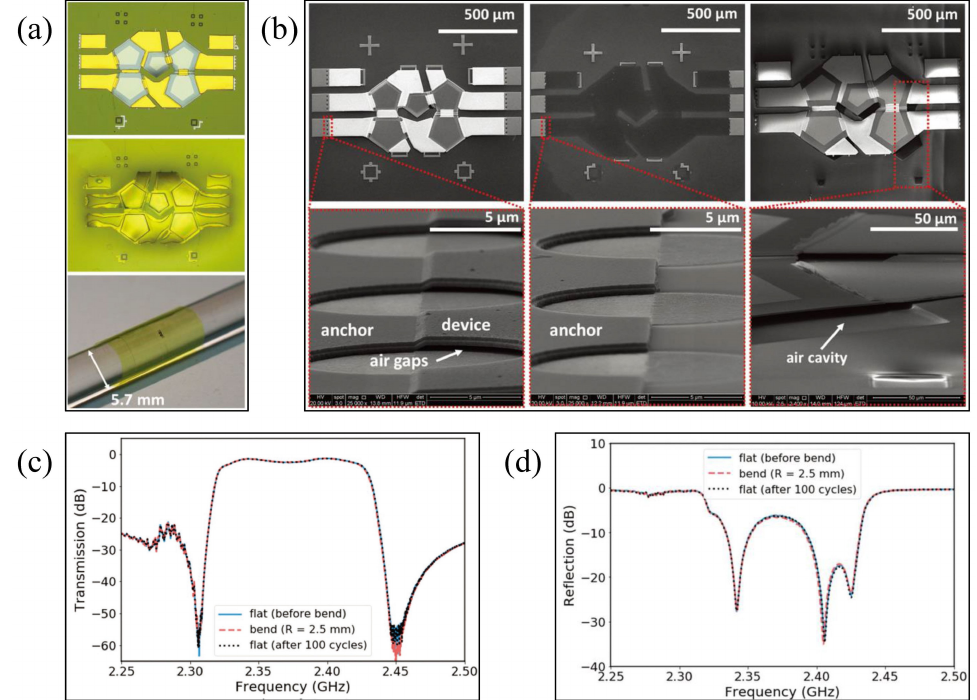
Figure 8. ( a ) Microscopic images of the flexible filter and the bent flexible filter [98] Reprinted/adapted with permission from Ref. [98]. 2018, John Wiley and Sons. ( b ) SEM images of the flexible filter [98] Reprinted/adapted with permission from Ref. [98]. 2018, John Wiley and Sons. ( c ) Transmission (S21) and ( d ) reflection (S11) performances of the flexible filter [98] Reprinted/adapted with permission from Ref. [98]. 2018, John Wiley and